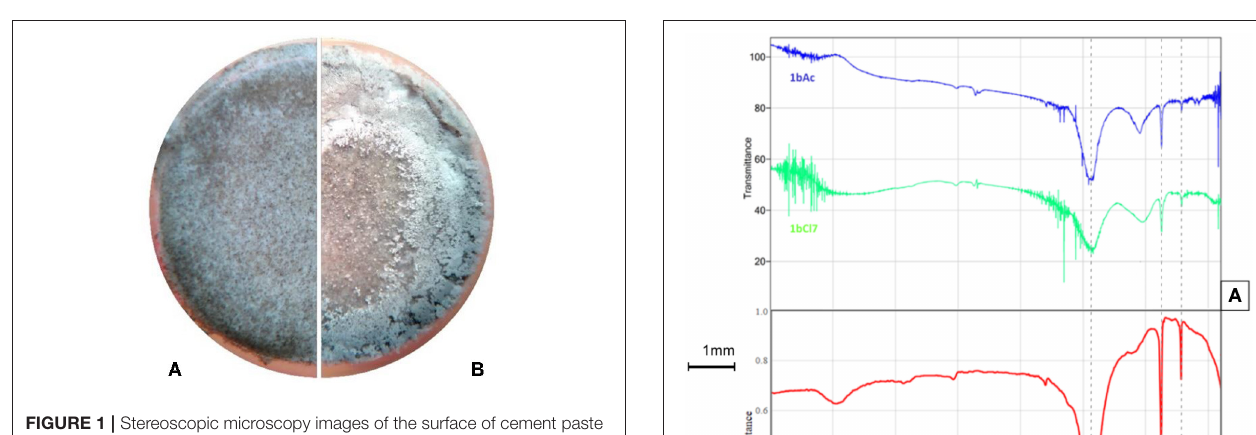
FIGURE 1 | Stereoscopic microscopy images of the surface of cement paste specimens. (A) Control –treated with CaCl 2 .but not bacterium (B) treated with L. sphaericus and CaCl 2 .